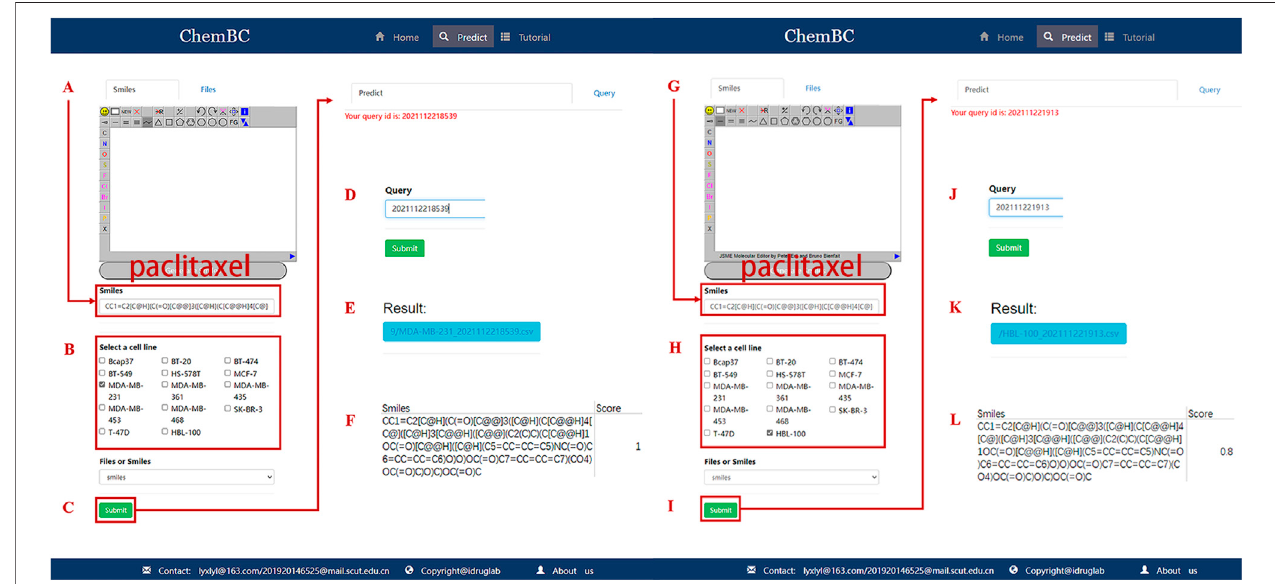
FIGURE 10 | Website schematic diagram of bioactivity prediction. (A – F) represents prediction of paclitaxel inhibition for MDA-MB-231 cell line. (G – L) represents prediction of paclitaxel inhibition against HBL-100 cell line.